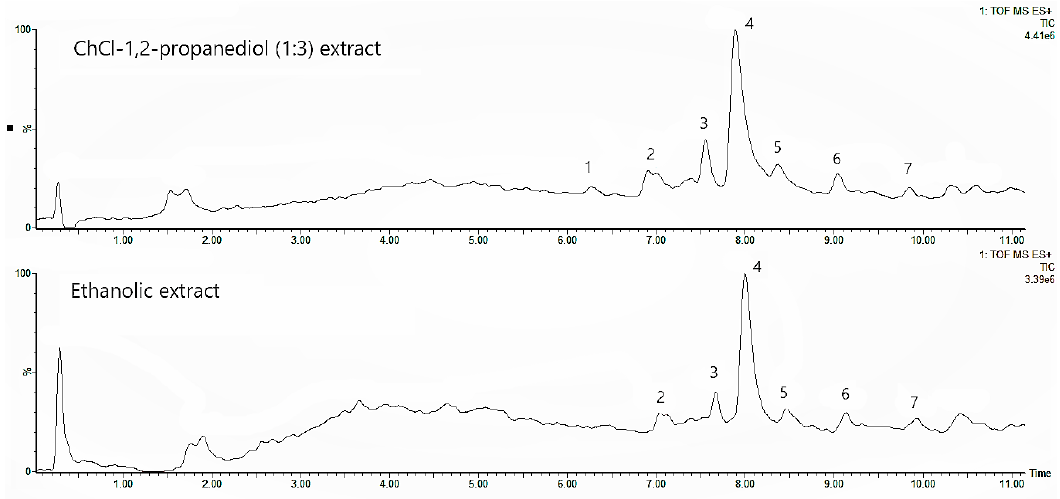
Figure 5. Chromatogram of the DES-2P3 (above) and ethanolic extracts (below). Numbers indicate the xanthone components identified using LC-MS: ( 1 ) 1,7-dihydroxy-3-methoxy-2-(3-methylbut-2- enyl)xanthon, ( 2 ) γ -mangostin, ( 3 ) gartanin, ( 4 ) α -mangostin, ( 5 ) garcinone E, (6 ) garcimangosone B, ( 7 ) β -mangostin.